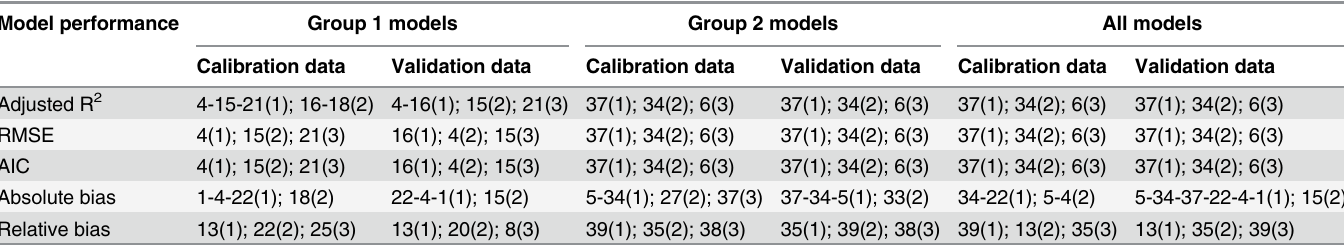
whereas for bias (both absolute and relative bias), the model with the value closest to zero was considered to be the best. For RMSE and AIC, the model with the lowest value had the highest ranking. For each model, its ranking for the five evaluation statistics was summated. The model with the smallest sum total (i.e. the highest overall ranking) was considered to be the best growth function for each of the Chinese-fir databases. According to this analysis, amongst the Group 1 models, Model 4 was the best model for the calibration dataset, whereas Model 16 was the best for the validation dataset. Model 15 ranked similarly for both the calibration and validation datasets. On the whole, there was little difference amongst the Group 1 models. The best-performing models — not only in Group 2 but across all models — were the nonlinear mod- els, Model 37 and Model 34, followed by the linear model, Model 6. The nonlinear models therefore performed a little better than the linear models. The observed heights versus the predicted heights for these models, for all datasets, are shown in Fig 5. The criterion used to evaluate the performance of a model was the determina- tion coefficient of the straight line between the observed and predicted heights (i.e., the solid line represents the diagonal). Each model had a relatively high R 2 , so the solid line was closely surrounded by the data points. No significant tendency towards overestimation or Table 5. Model rank based on